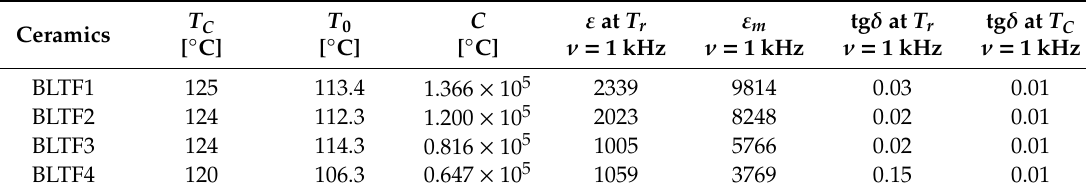
Table 2. Influence of the amount of iron admixture on the BLTF ceramics dielectric parameters: T c —Curie temperature, T 0 —Curie-Weiss temperature, C —Curie constant, ε —dielectric permittivity at room temperature (Tr), ε m —maximum value of dielectric permittivity at T c , tg δ —dielectric loss at T r